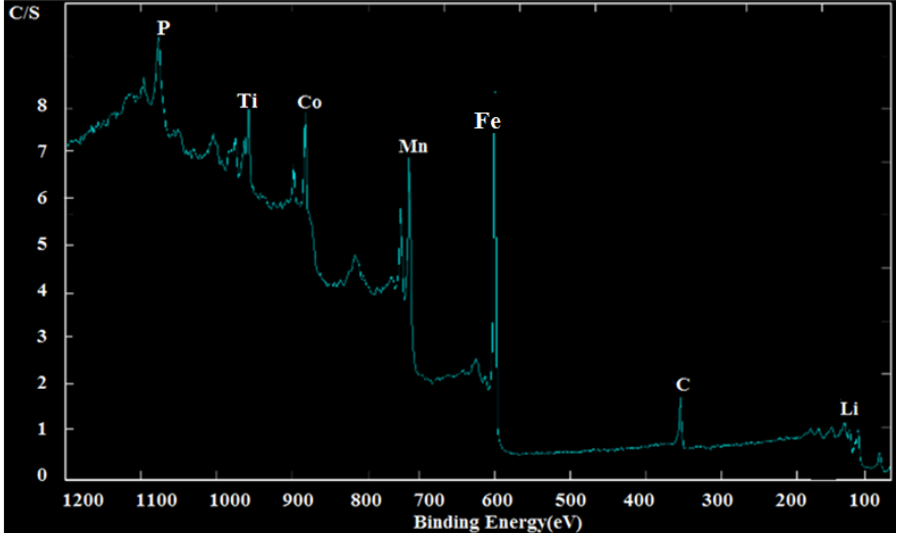
Figure 8. XPS plots for samples 18.